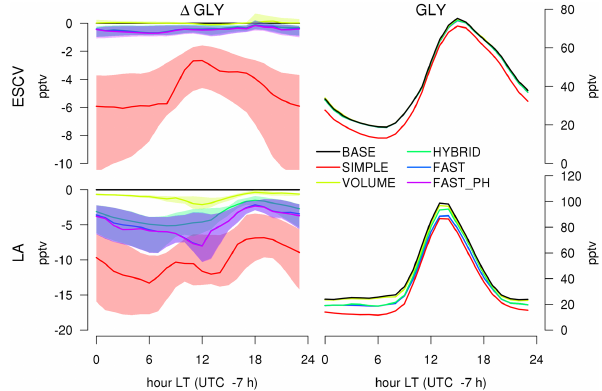
Figure 14. Changes in gas-phase glyoxal due to the different pa- rameterizations of the aerosol sink relative to the BASE simulation. Shown are diurnal cycles for differences relative to the BASE simu- lation (left plots) and absolute concentrations (right plots) in the two focus regions, averaged over the simulation period. Shaded areas in differences represent the 25–75% value